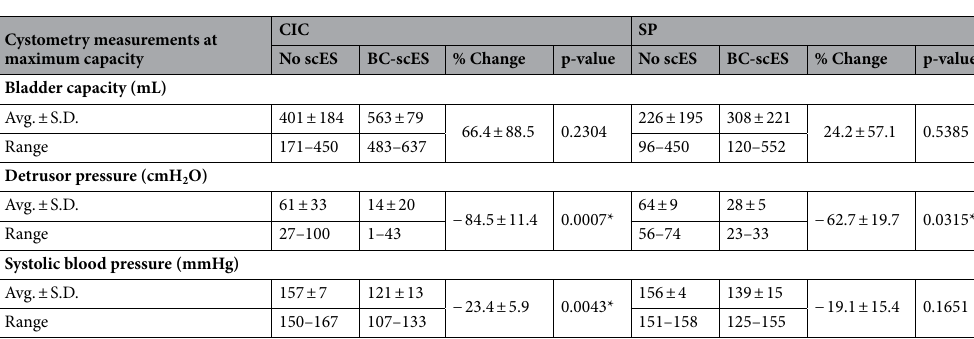
Cystometry measurements at maximum